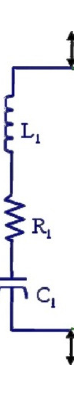
Figure 9. Elementary model of a piezoelectric resonator based on passive elements.